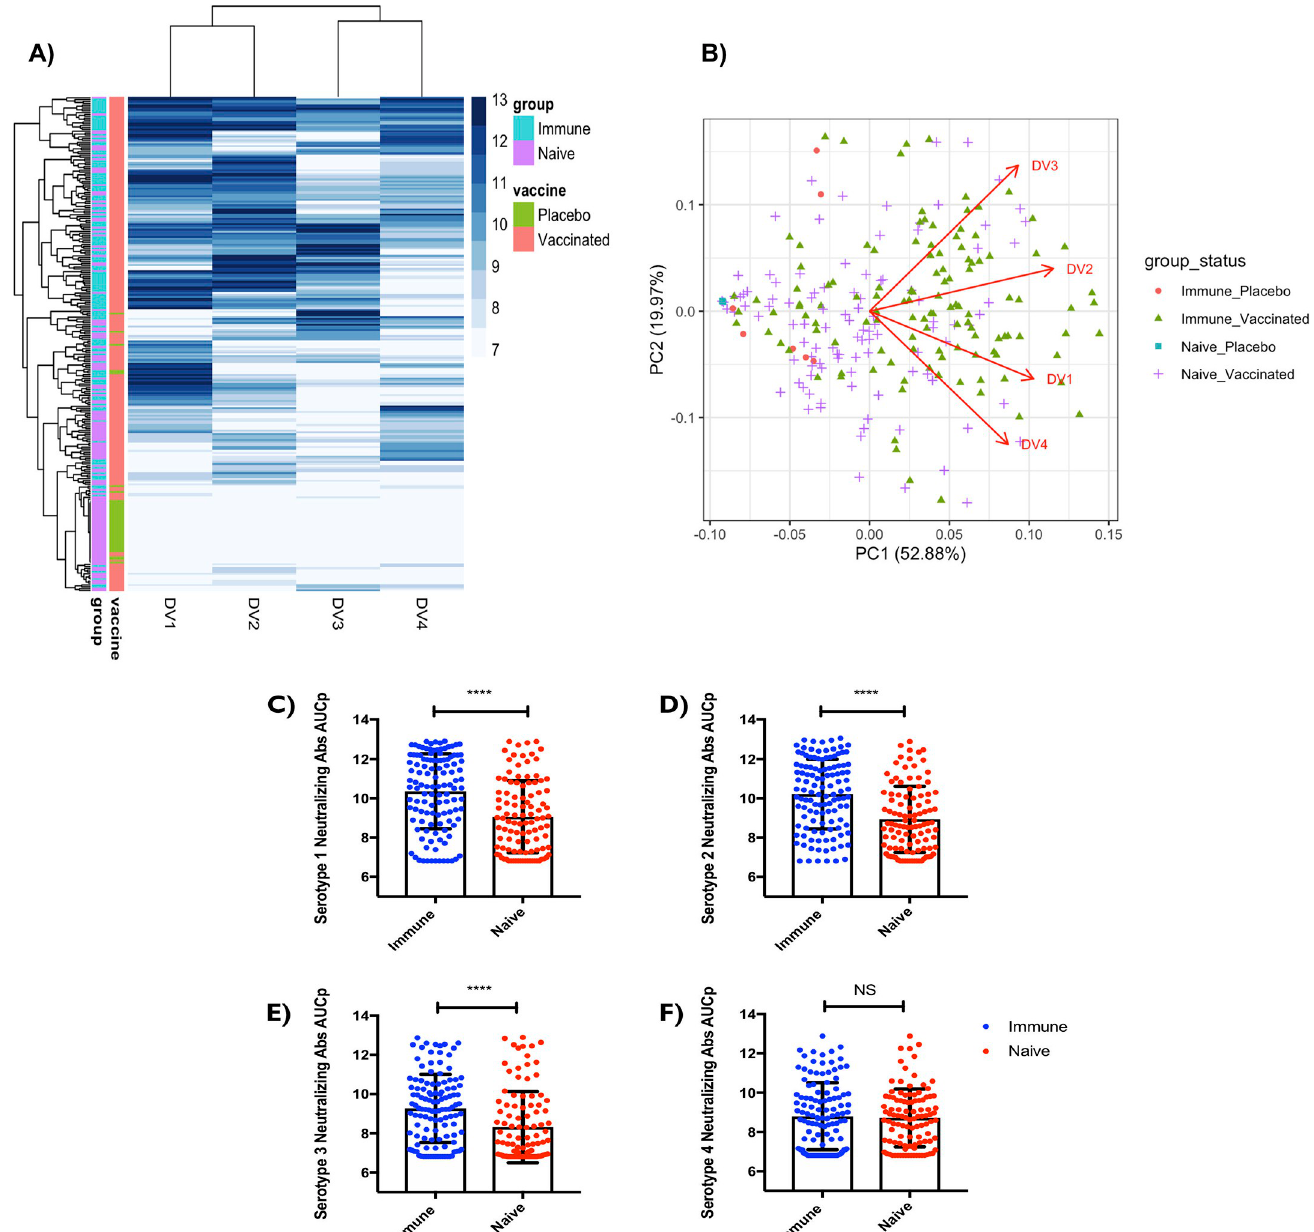
Fig 1. Response to dengue vaccine is variable and impacted by the pre-vaccination immune status. (A) Heatmap of subject AUC values. For each subject there are four AUC values represented in DV1, DV2,DV3 and DV4 columns. The higher AUC value is represented by a darker blue strike. Two columns to the left of the graph help to distinguish the vaccine status and which group subjects belong to. (B) Biplot for 266 subjects DV1-4 AUC values plotted in two dimensions on first two principal components and DV1-4 vectors indicating each’s contribution to PC1 and PC2. Samples are colored according to their baseline/pre-vaccination immune status and whether they received the dengue vaccine. (C) Y axis is Dengue Serotype 1 neutralizing antibody titers (AUCp). (D) Y axis is Dengue Serotype 2 neutralizing antibody titers (AUCp). (E) Y axis is Dengue Serotype 3 neutralizing antibody titers (AUCp) (F) Y axis is Dengue Serotype 4 neutralizing antibody titers (AUCp). This was accomplished using plaque reduction neutralization test (PRNT). (Immune n = 119, Naive n = 105). Unpaired non-parametric Mann Whitney test, 95% confidence was calculated for (C-F). Before vaccination, seropositive subjects with existing antibodies to any of the four Dengue virus serotypes due to prior infection were referred to as (“Immune”), or seronegative subjects with no existing antibodies to any of the four Dengue virus serotypes were referred to as (“Na ï ve”). Nominal p-values p < 0.05 were considered statistically significant. � p < 0.05, �� p < 0.01 and ��� p < 0.001. ���� p < 0.0001.